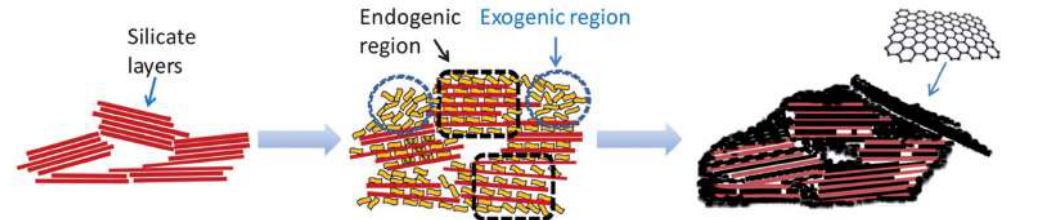
Figure 3. Schematic representation of graphene-like materials formed inside sepiolite pores (endo- genic regions) and epitaxially grown on the sepiolite surface (exogenic regions). Reproduced with permission from Ruiz-García et al., J. Mater. Chem. A 2017, 2009 , published by the Royal Society of Chemistry [88].